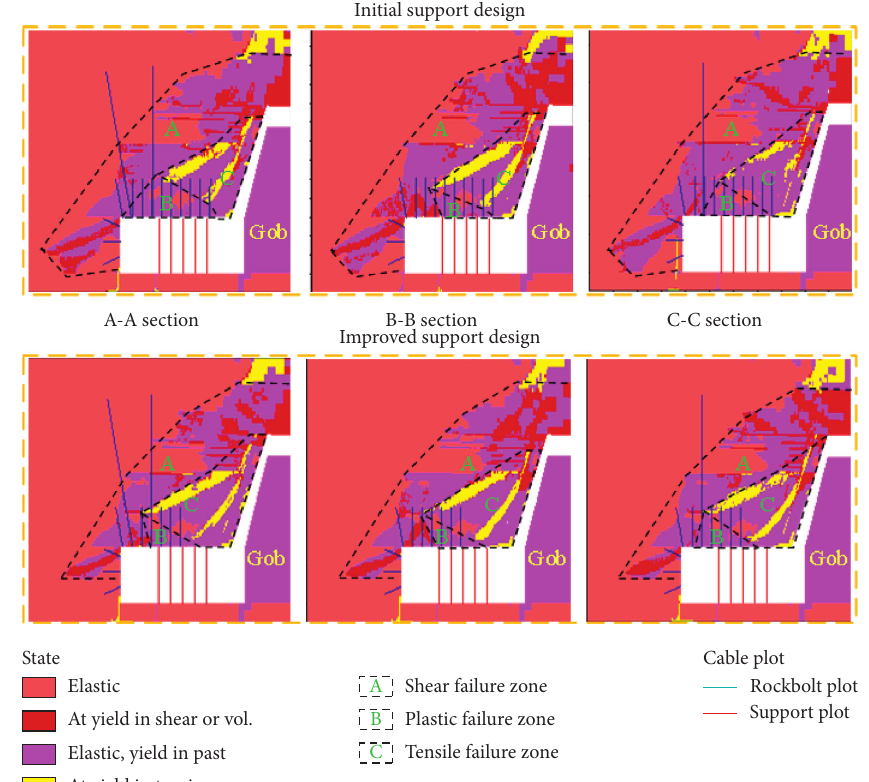
Figure 15: Plastic zone distribution of the two support designs.